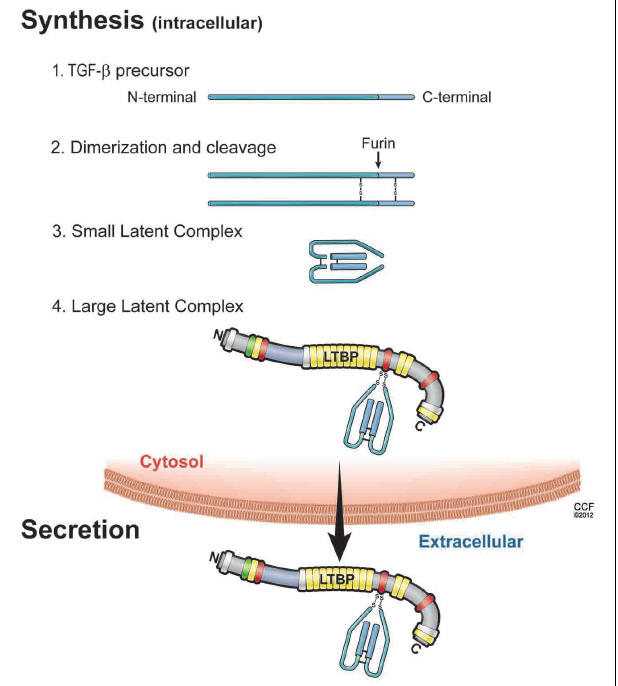
FIGURE 1 | Illustration of the sequential steps in the synthesis ofTGF- β latent complex and secretion. (1)TGF- β is synthesized as a precursor protein; (2)TwoTGF- β precursor proteins dimerize through disulfide bridges; (3)TGF- β -dimer precursor is cleaved by furin to yield the small latentTGF- β complex, in which latency-associated peptide (LAP; light blue) and mature TGF- β peptide (dark blue) are connected by non-covalent bonds; and (4) the large latent complex is formed by covalent linking between small latent complex and latentTGF- β binding protein (LTBP), then secreted and incorporated into extracellular